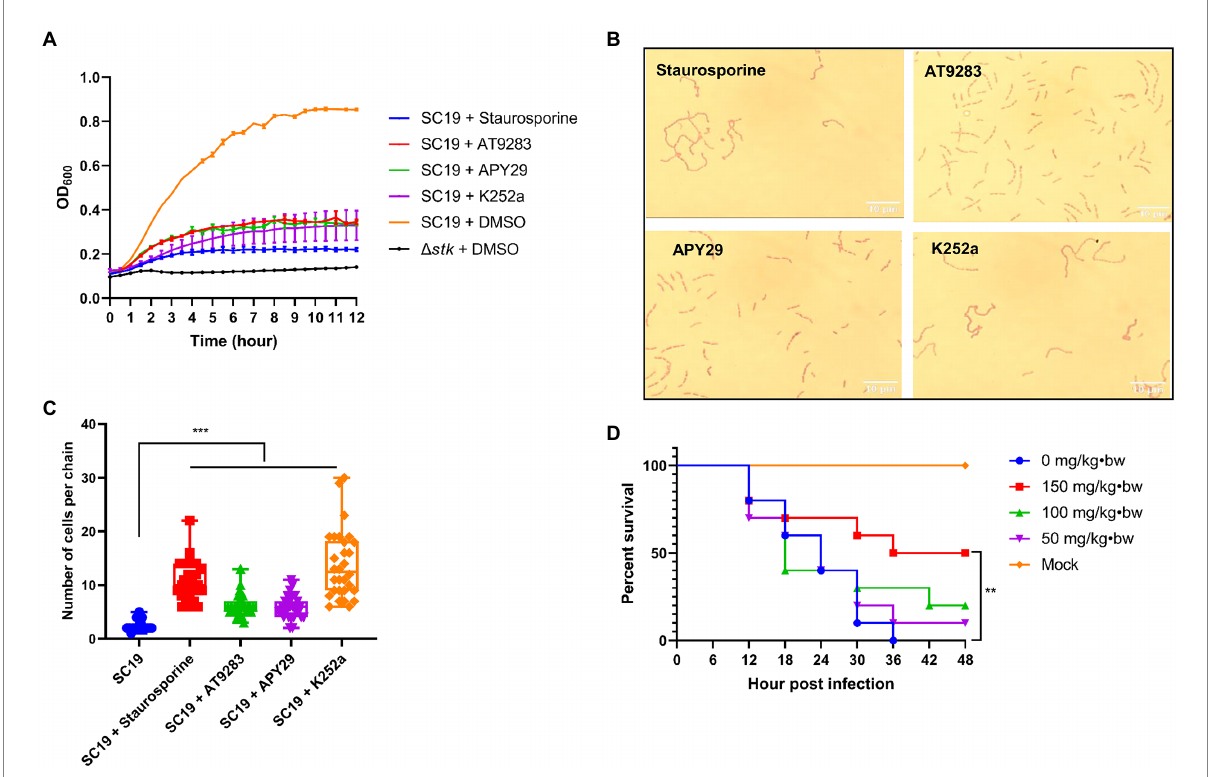
FIGURE 7 Characterizations of the STK inhibitors. (A) Growth assay. Cells of S. suis SC19 and Δ stk were grown in the CDM in the presence and absence of the STK inhibitors, and the OD 600 was measured; (B) Influence of the STK inhibitors on the morphology of S. suis . Streptococcus suis SC19 cells were co-cultured with each inhibitor in TSB medium to the log-phase. The cells were harvested, washed, and subjected to Gram staining followed by observation using an optical microscope. (C) 30 chains of were randomly chosen from each Gram staining images of SC19 treated with Staurosporine, AT9283, APY29, and K252a, respectively. Next, numbers of cells per chain were counted, respectively, and the data were presented as the means ± standard errors ( n = 30). Student’s t -test was used to analyze their chain length difference in GraphPad Prism 7 software, with the value of p < 0.001, ***. (D) G. mellonella larvae infection assay. Galleria mellonella larvae were inoculated with APY29 at 150, 100, 50, and 0 mg/kg•body weight after S. suis SC19 infection. The survival was recorded every 6 h for 48 h. The survival data were analyzed by log − rank test in GraphPad Prism 7 software, with a value of p < 0.01, **. The experiments were carried out two times independently under the same